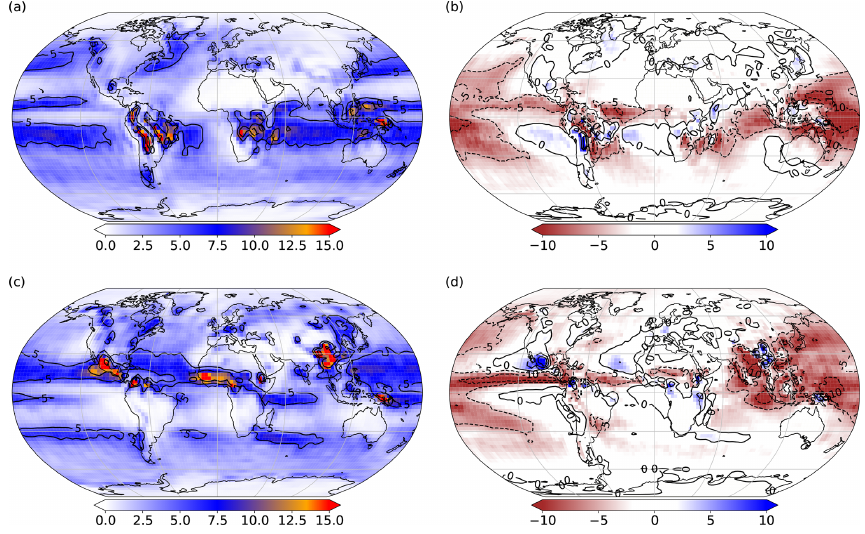
Figure 5. Time mean (years 2001–2025) plots from the L35 configuration showing precipitation (mmd − 1 ): (a) DJF, (b) DJF anomaly from 20CR years 1871–1896, (c) JJA and (d) JJA anomaly from 20CR years 1871–1896.